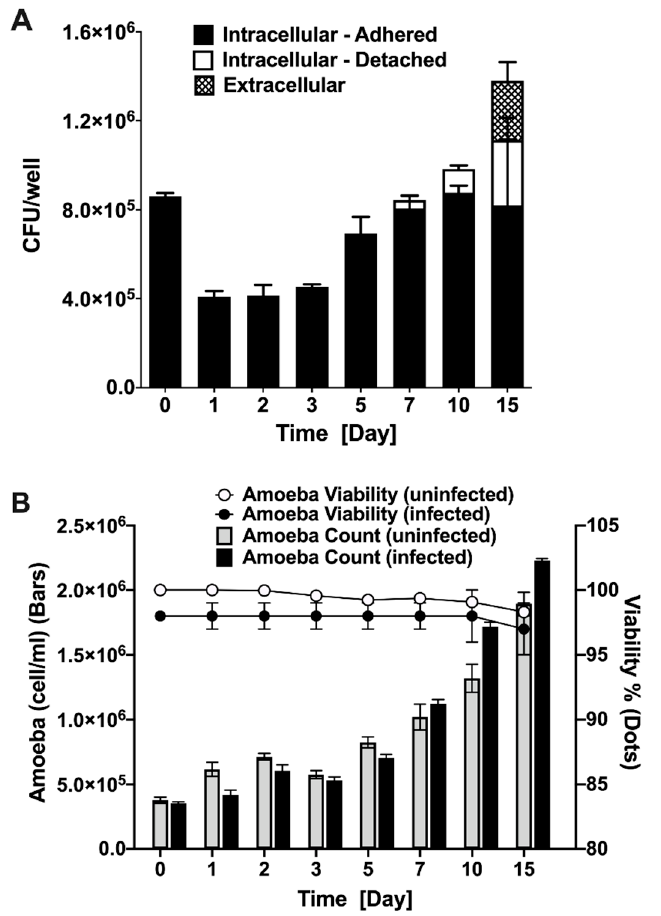
Figure 2. MAP and amoeba viability during infection. Amoeba was infected with MAP at MOI of 10 for 1 h followed by three washing steps and 2 h amikacin (200 μ g/mL) treatment to remove extracellular MAP. ( A ) Both detached and attached amoeba were lysed and intracellular MAP was quantified with colony forming unit (CFU) counts. At each indicated time points, supernatants were also collected to quantify extracellular MAP. ( B ) The amoeba growth and viability in MAP-infected experimental and uninfected control groups were determined using trypan blue staining. The amoeba number was quantified over 15-day course of infection and data is presented as a bar chart. The dot chart shows the percentage of viable amoeba in both groups. Both MAP and amoeba data represent the mean ± SD of wells assayed in triplicate and is representative of two independent experiments.